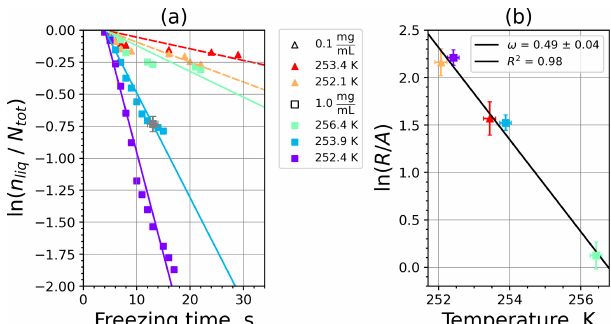
Figure 7. (a) Frozen fraction of 2mm aqueous-suspension droplets containing 1.265gL − 1 kaolinite measured in the M-AL. (b) INAS density of kaolinite as a function of temperature determined from the spectrum shown in (a)